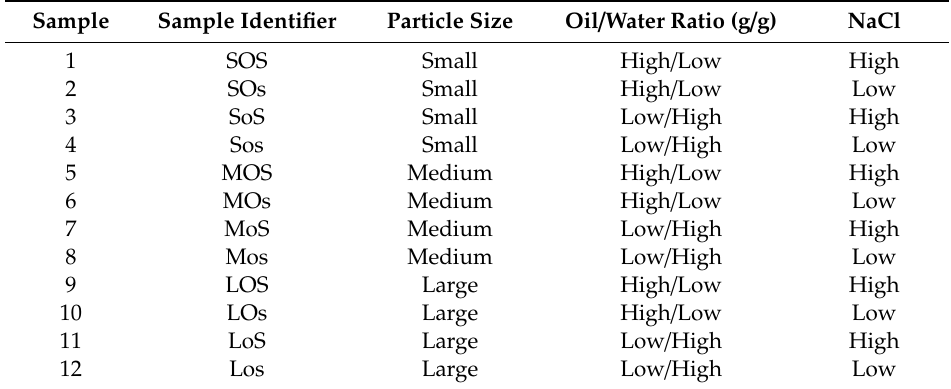
Samples Identifier: 1st letter refers to particle size (S, M, L), 2nd letter refers to oil / water ratio with o = small amount of oil and O = high amount of oil, 3rd letter refers to NaCl content with S = high amount and s = low